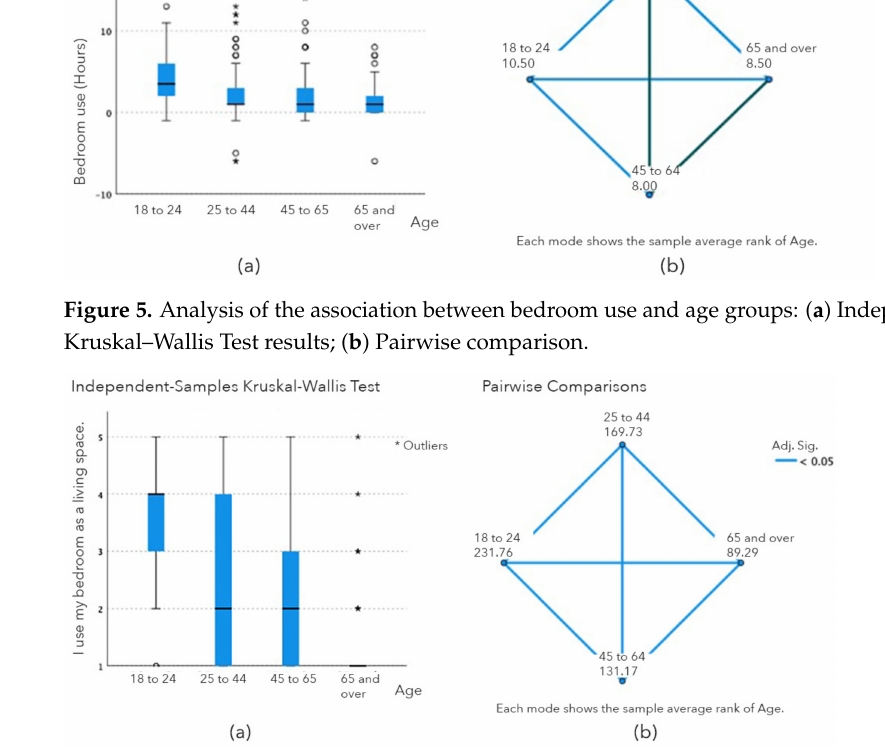
Figure 6. Analysis of the association between “using the bedroom as a living space” and age groups: ( a ) Independent samples Kruskal–Wallis Test results ( b ) Pairwise comparison.